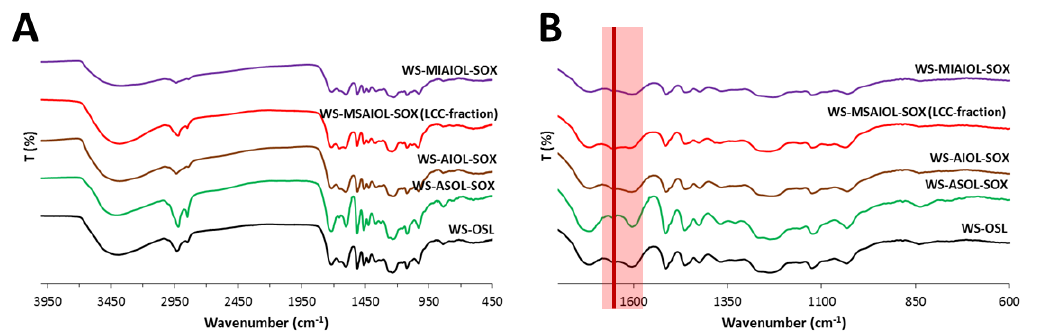
Figure 4. FT-IR spectra of WS-OSL and fractions derived thereof: full spectra ( A ); and fingerprint region ( B ).